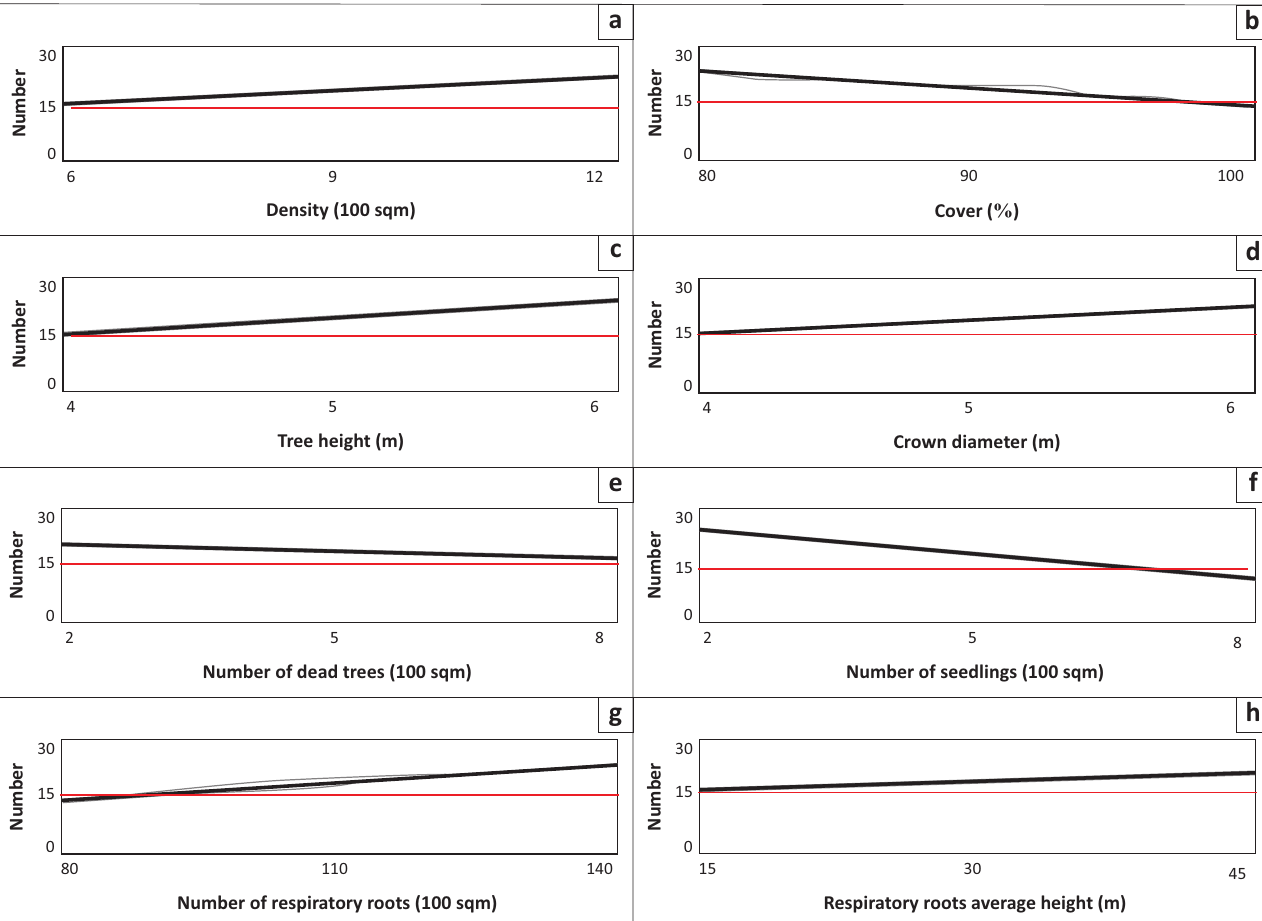
FIGURE 6: Sehat demographic features sensitivity analysis: (a) Density (100 m 2 ); (b) Cover ( % ); (c) Tree height (m); (d) Crown diameter (m); (e) Number of dead trees (100 m 2 ); (f) Number of seedlings (100 m 2 ); (g) Number of respiratory roots (100 m 2 ) and (h) Average height of respiratory roots